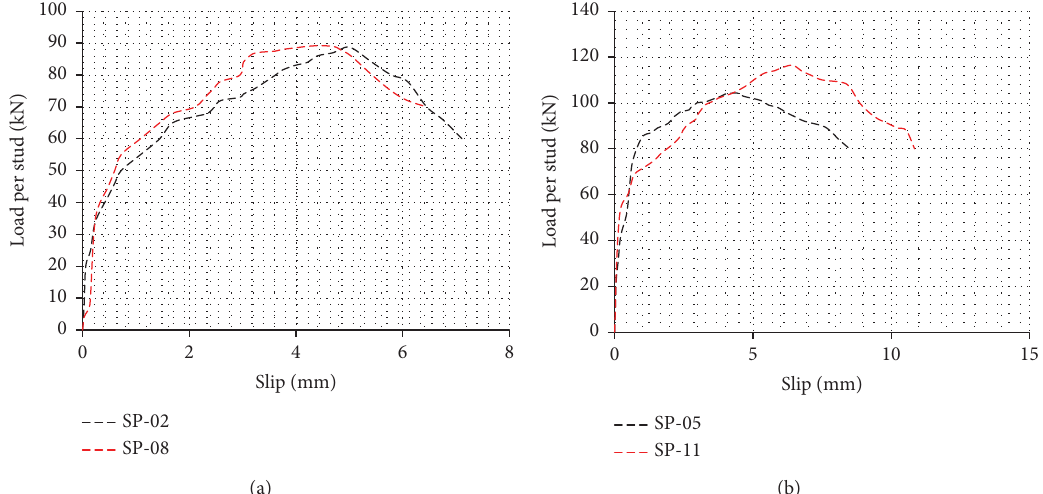
Figure 10: Effect of change in diameter of the connector on the capacity of shear connection with open through profiled steel sheeting [(a) d � 19mm and (b) d � 22mm].